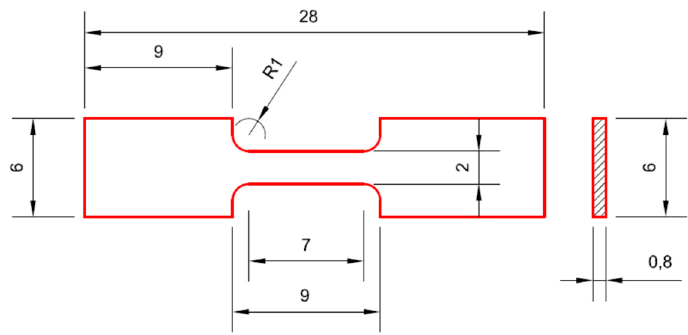
Figure 2. Geometric configuration of samples used in mechanical testing (tensile tests).